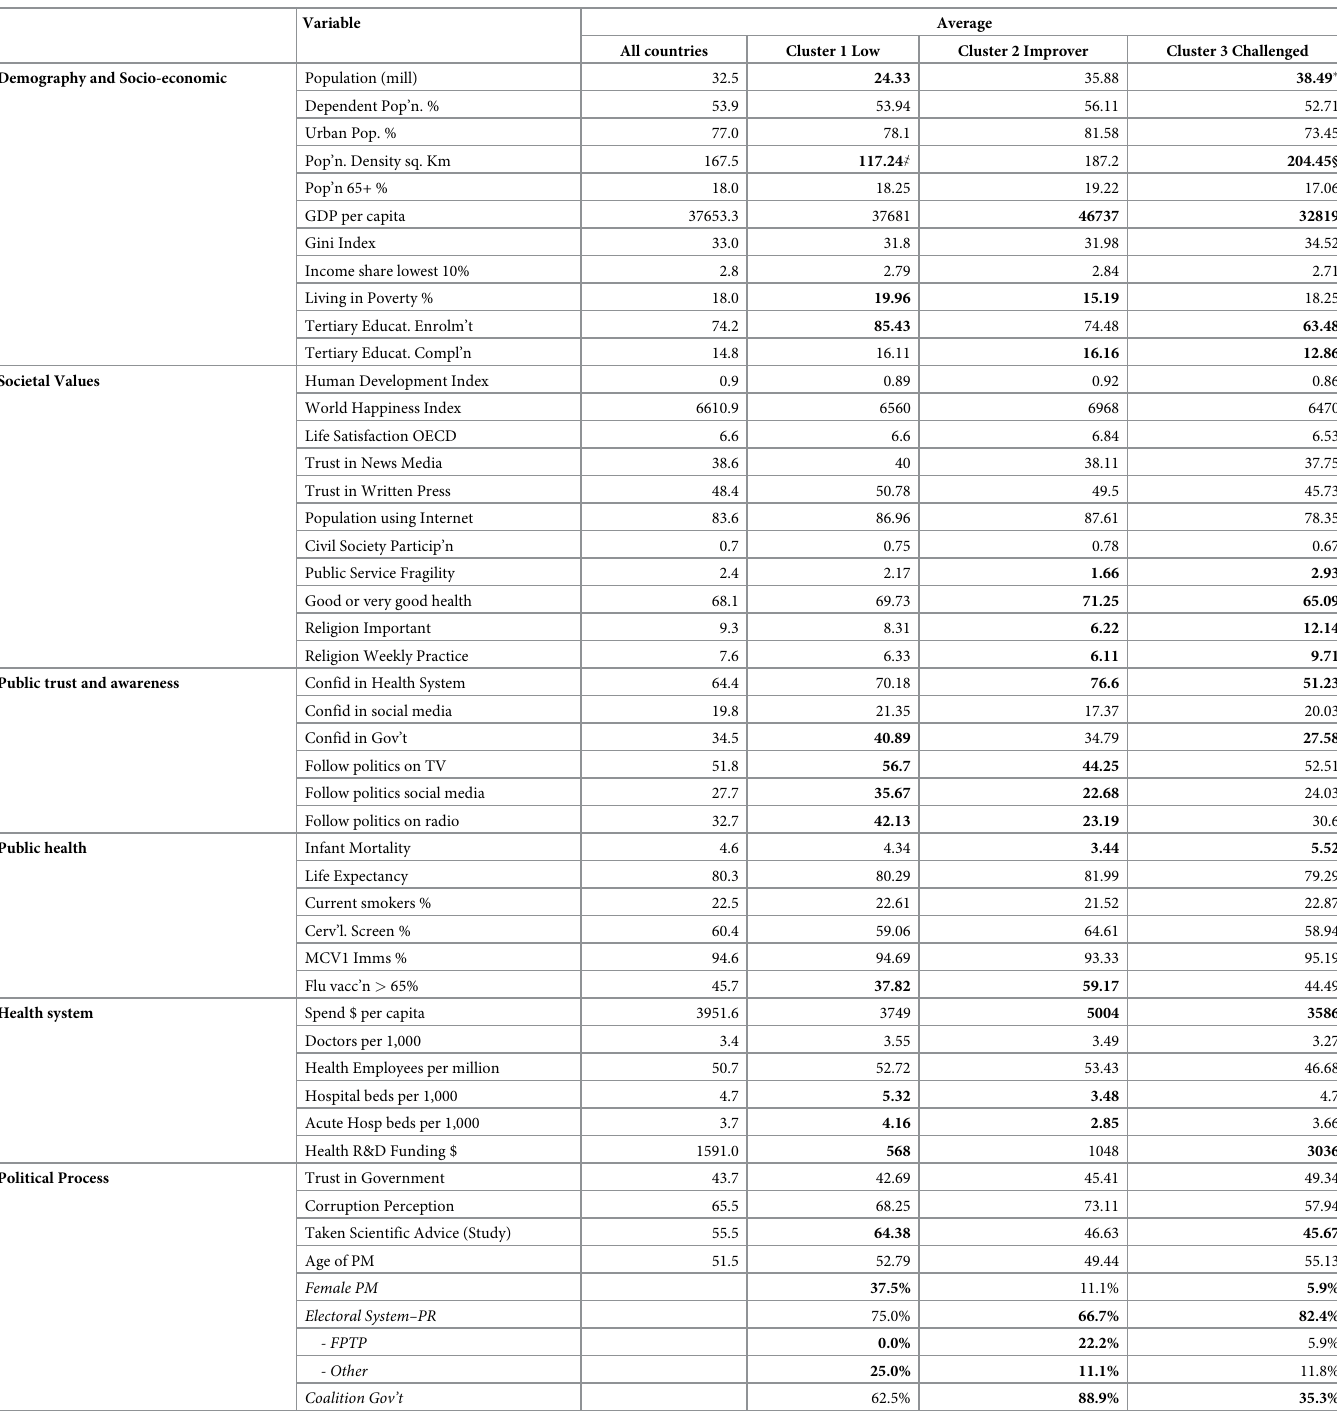
Table 7. Characteristics highlighted by